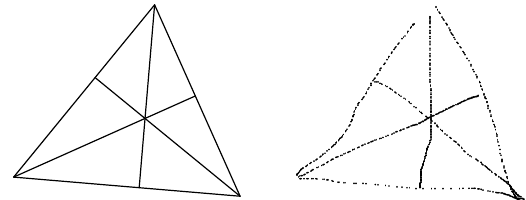
Figure 1. Orthocenter of a triangle. Left: construction, right: intended freehand strokes as user